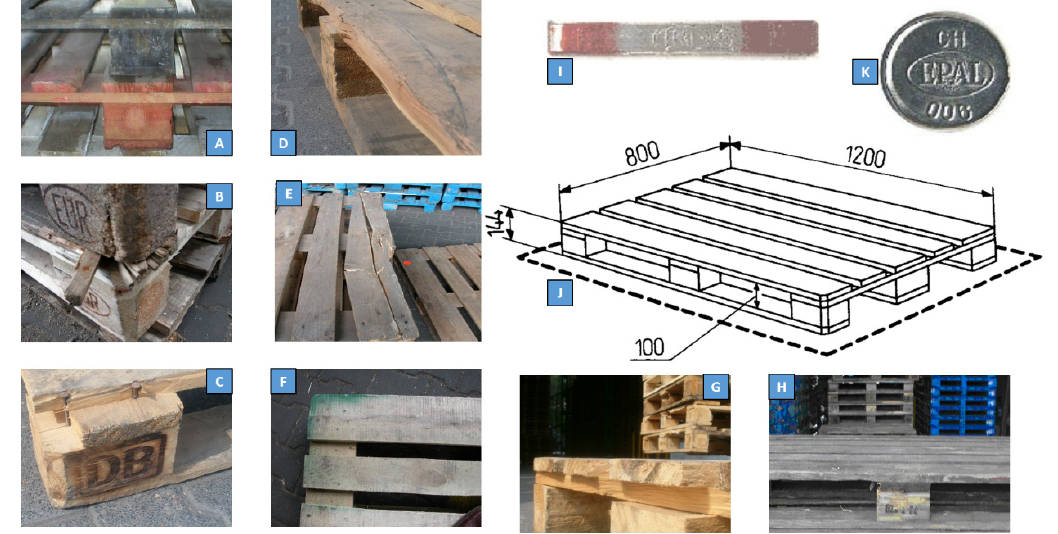
Figure 2. Damage to the pallets: (A-K) discussed in the text.